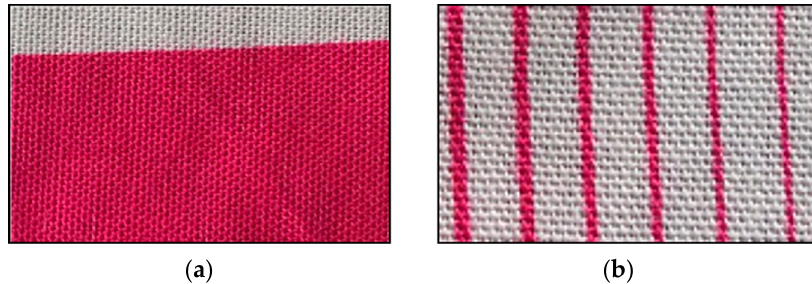
Figure 11. The images of cotton fabrics printed with 30% PEG600–dye solution: ( a ) The printed fabric, ( b ) The lines printed.